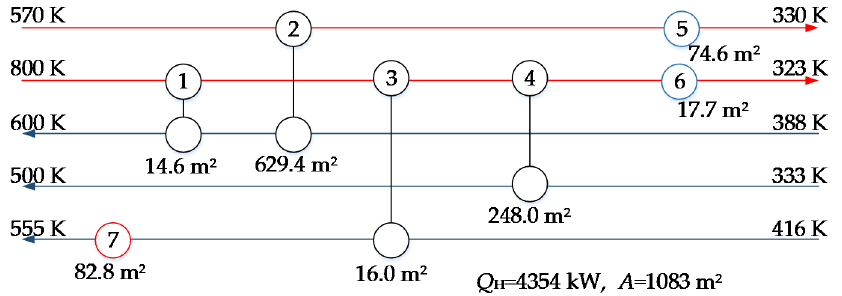
Figure 7. Optimal network of heat exchangers determined by deterministic approach (equal time periods).